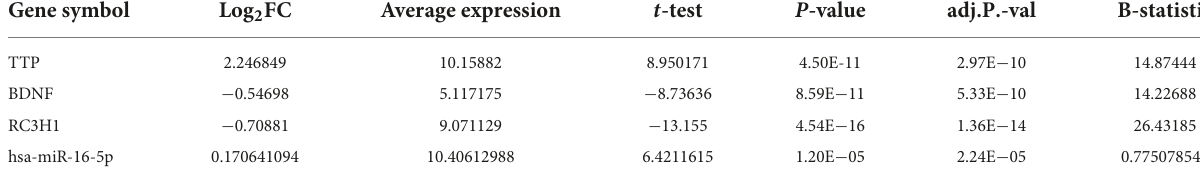
TABLE 2 Expression levels of TTP, RC3H1, BDNF, and miR-16 genes in TC tissue samples.